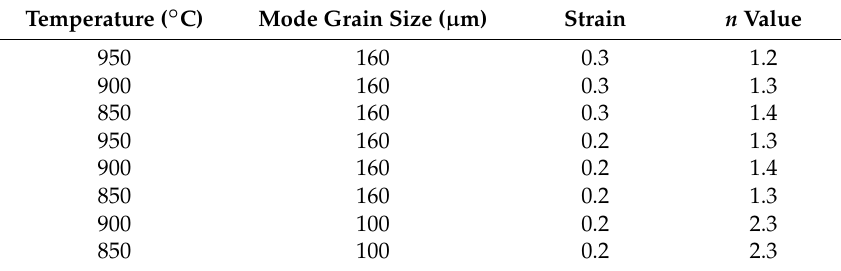
Table 1. Summary of experimentally determined Avrami exponents.